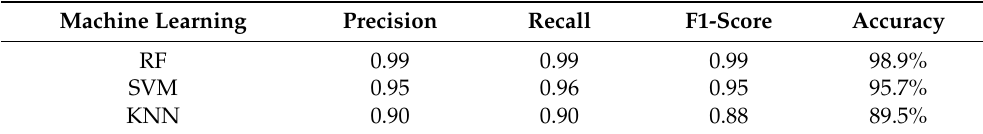
Table 5. Classification results of different machine learning algorithms.